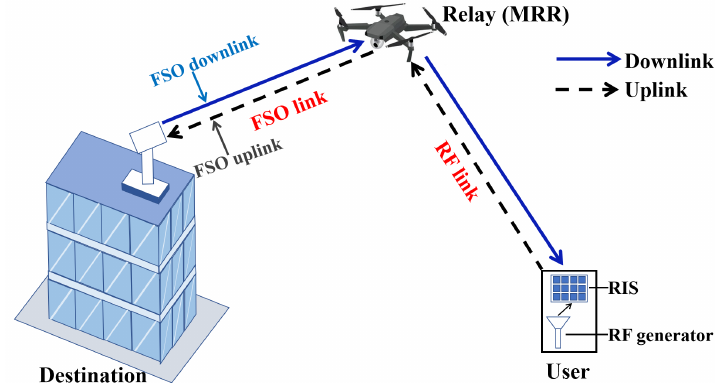
Figure 1. A mixed RF/FSO UAV communication system based on MRR and